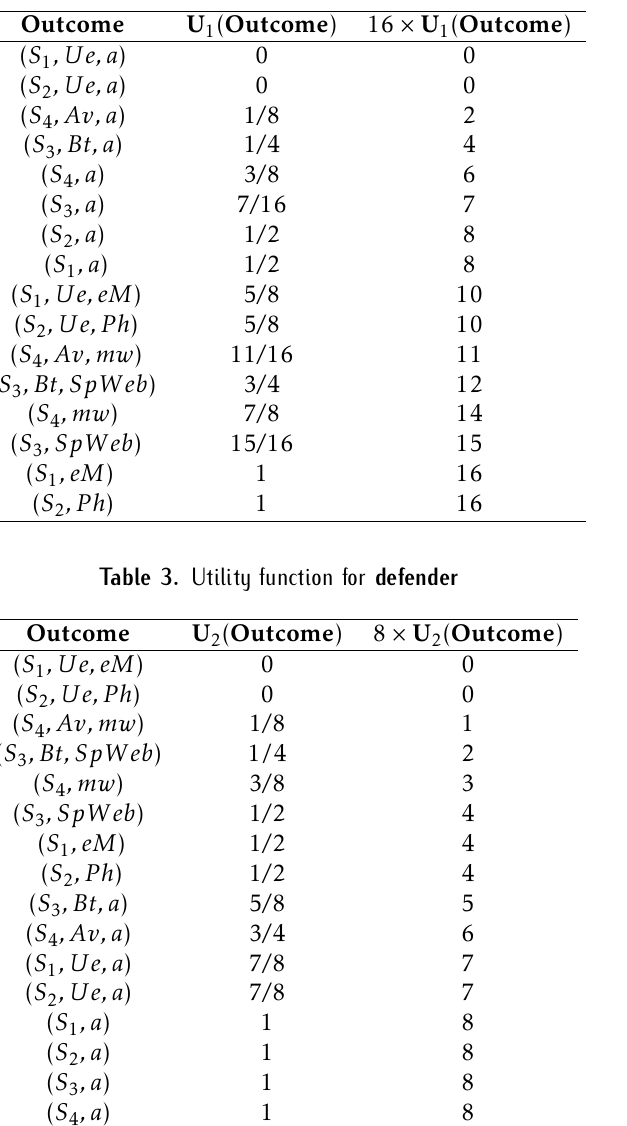
Figure 2. Extensive form of the phishing game under Gambit